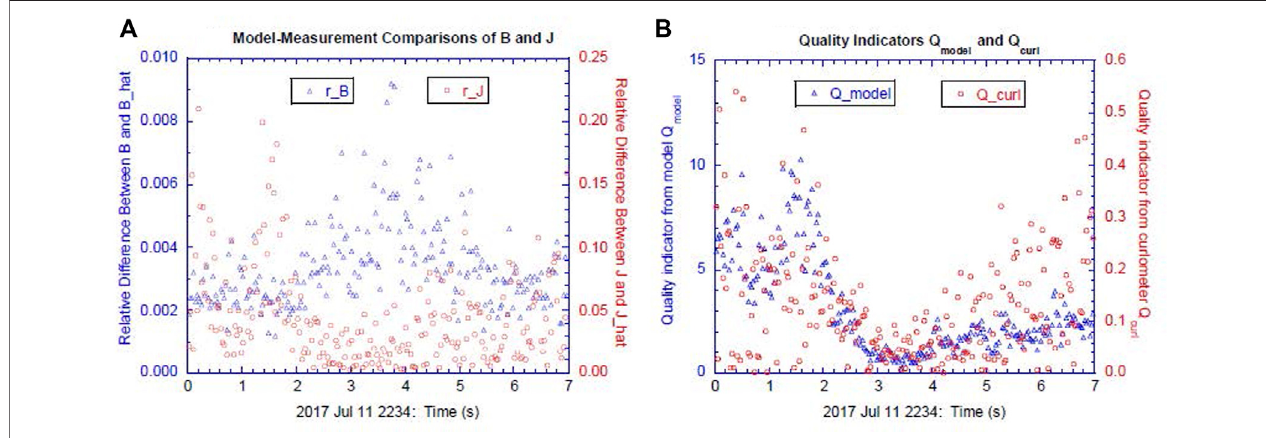
FIGURE 7 | (A) Relative differences ( γ B , γ J ) and (B) quality indicators ( Q model , Q curl ) for a sensitivity run with weighting factors w B and w C being both set to 0: , w ) (cid:1) ( 0 , 0 ) ( w B C